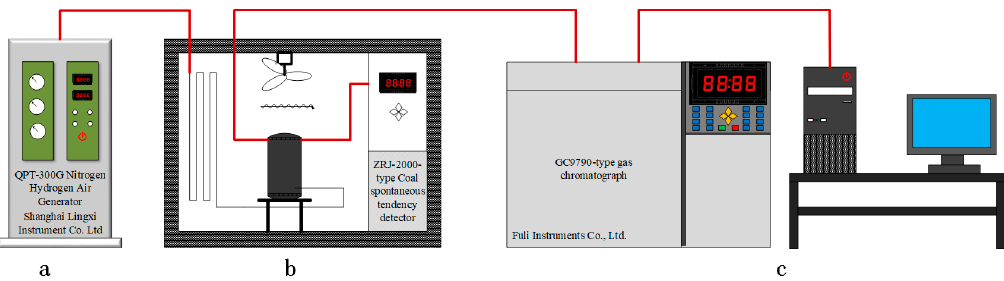
Figure 1. Programmed heating system.